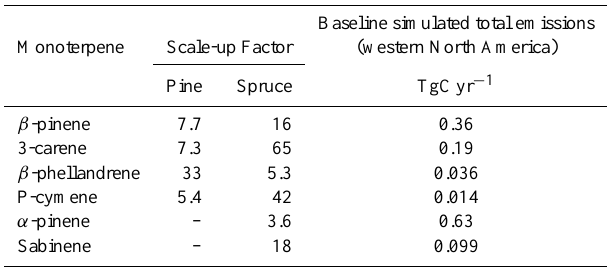
Table 1. Scale-up factors for bark beetle-induced changes in monoterpene emissions calculated from Amin et al. (2012, 2013) lodgepole pine and Engelmann spruce